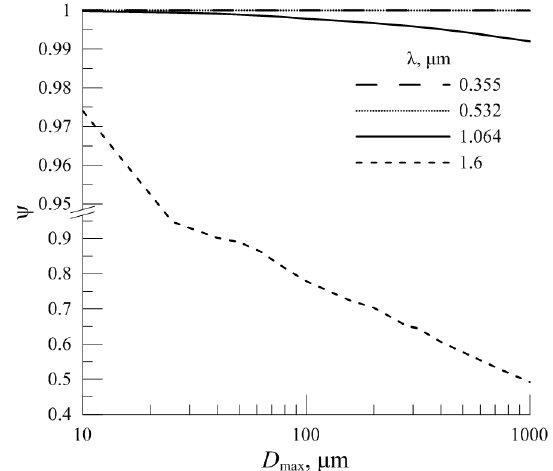
Figure 3(a) Dependence of D on (cid:4) for the solid max hexagonal